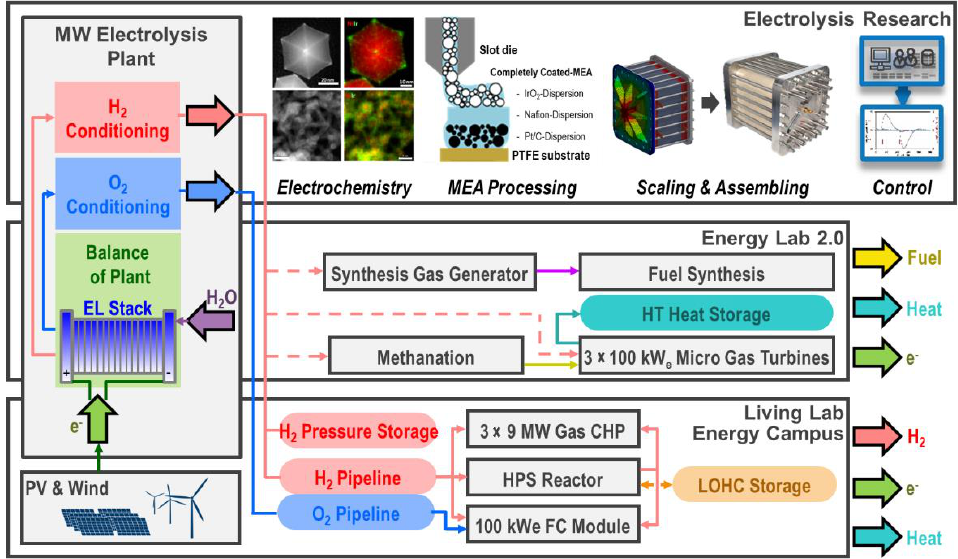
Figure 1. The MW electrolysis system as the focus of research.